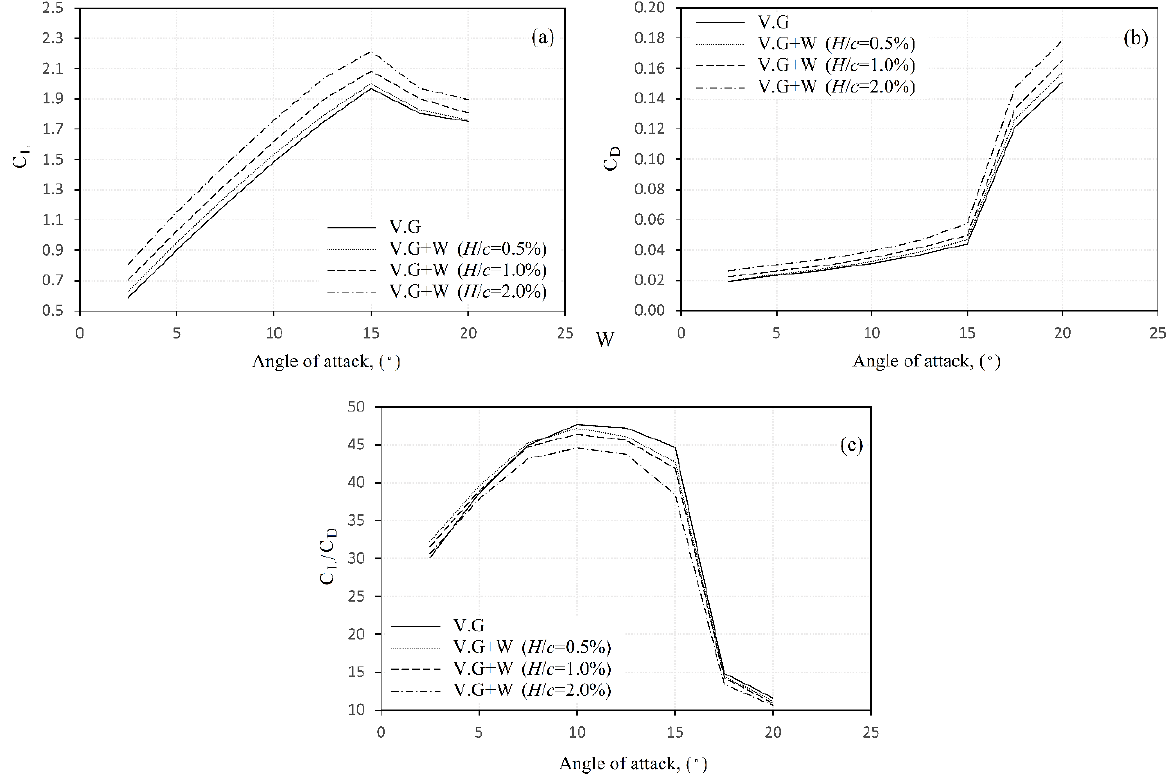
Figure 14. Lift coefficient, drag coefficient and aerodynamic performance for the airfoil equipped with VGs in the presence of trailing-edge